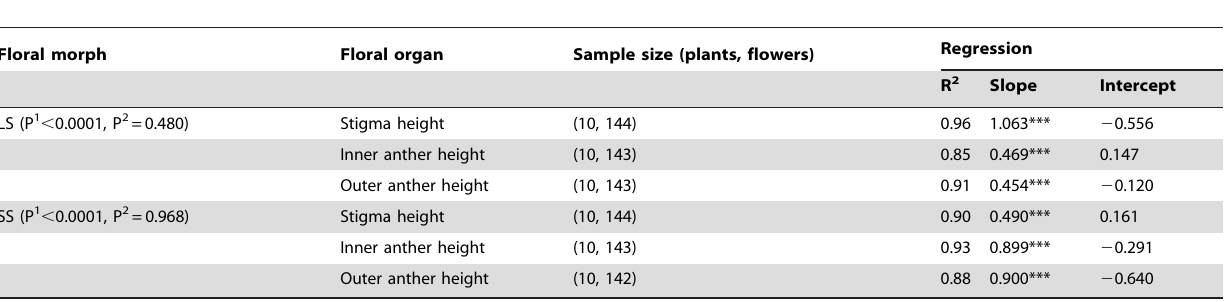
Table 1. Relationship between floral organ height and bud length in long-styled (LS) and short-styled (SS) flowers of Polygonum jucundum.